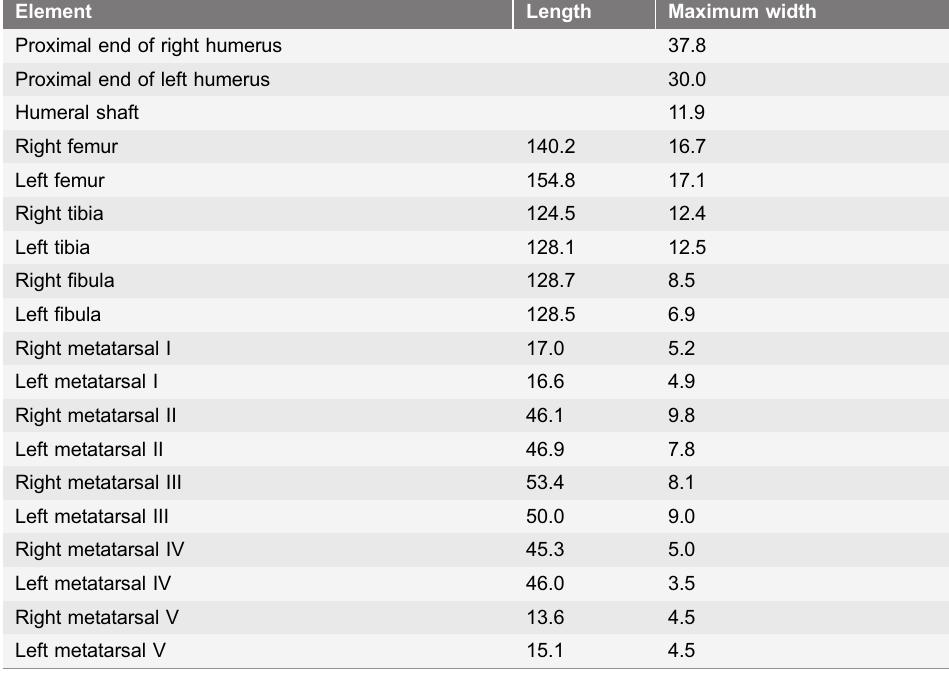
Table 2. Measurements of appendicular bones of Pseudochampsa ischigualastensis (PVSJ 567) in millimeters. Element Length Maximum width Proximal end of right humerus 37.8 Proximal end of left humerus 30.0 Humeral shaft 11.9 Right femur